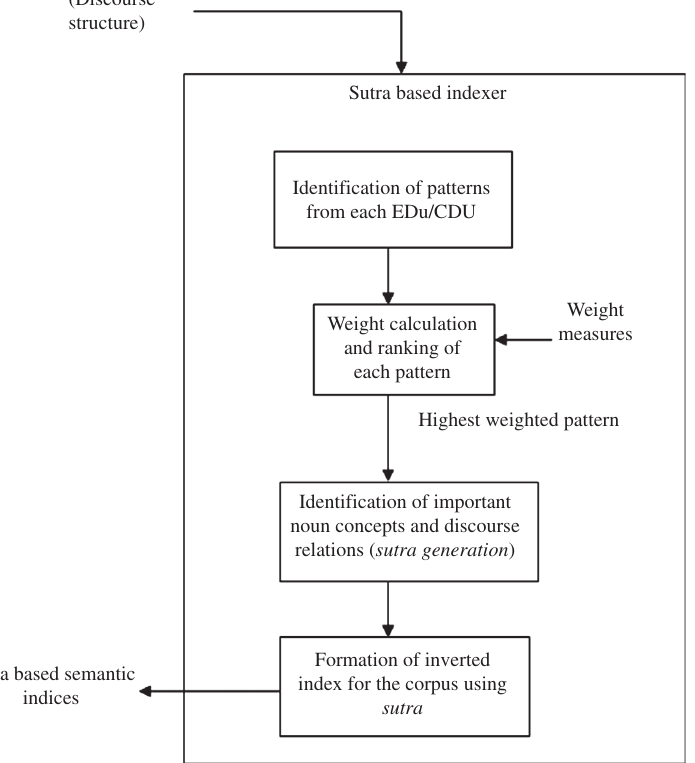
Figure 4. Architecture of Sutra - Based